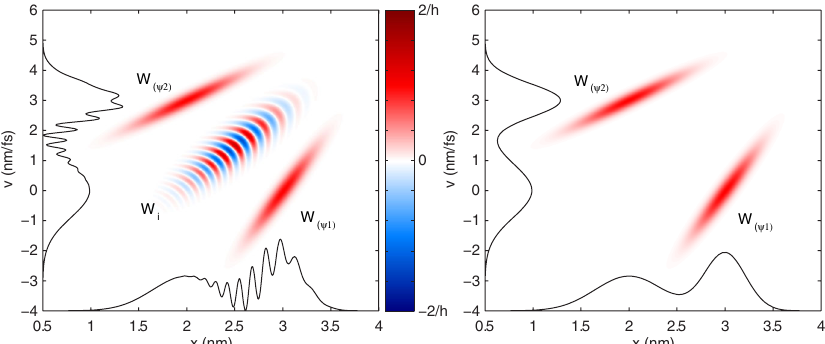
FIG. 5. The Wigner distribution for coherent (left) and incoherent (right) superposition of two quantum states with equal weights. Solid curves show projections of the WDF, probability densities in position and velocity, respectively. The states are of the form c ð x Þ / e (cid:2) (cid:1) x 2 = 2 (cid:12) 2 x e i ð m= @ Þ½ v 0 (cid:1) x þð 1 = 2 Þð dv=dx Þ (cid:1) x 2 (cid:8) , where (cid:1) x ¼ x (cid:2) x 0 . The parameters f x 0 ; (cid:12) f 3 nm ; 0 : 3 nm ; 0 nm = fs ; 4 fs (cid:2) 1 g and f 2 nm ; 0 : 5 nm ; 3 nm = fs ; 1 : 5 fs (cid:2) 1 g for the two Gaussian states